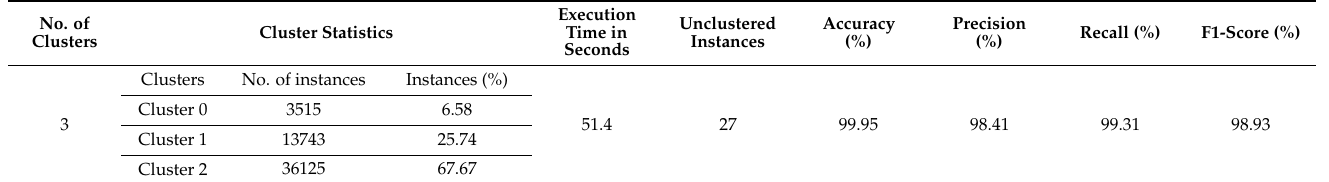
Table 4. Algorithm performance factors for main clusters.